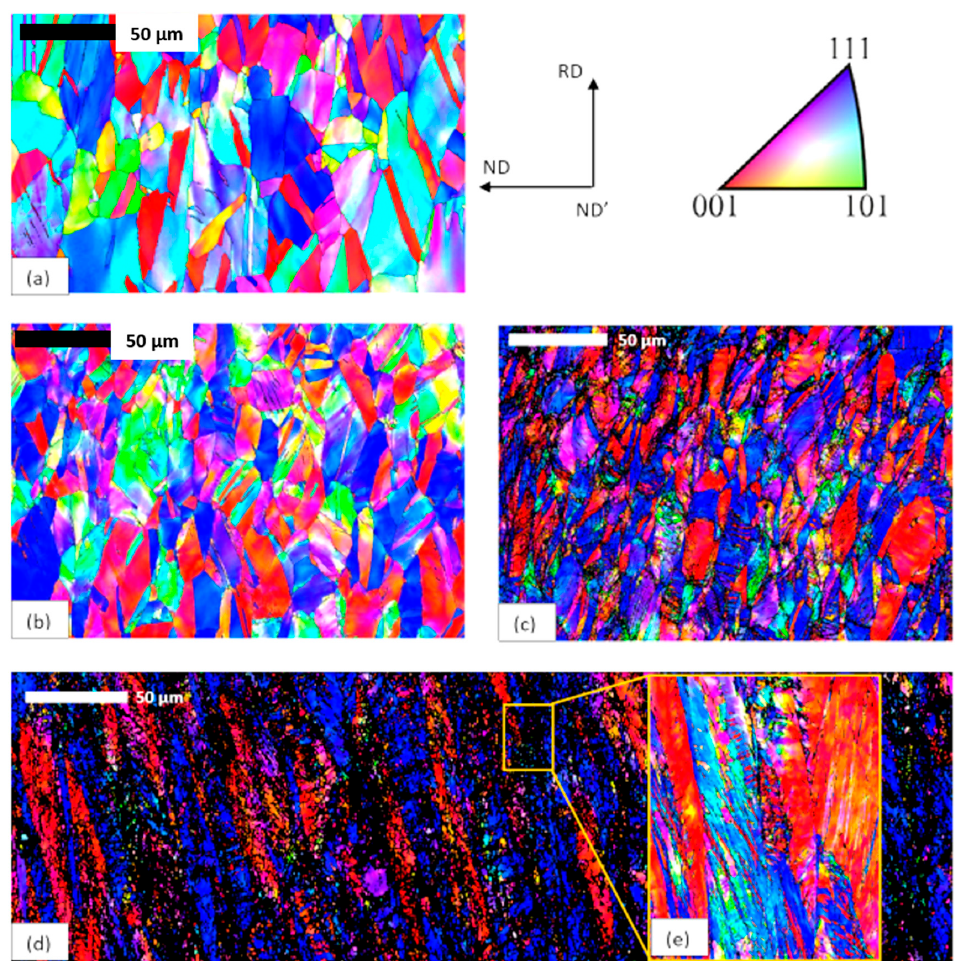
Figure 5. EBSD-band contrast maps described by inverse figure pole (IFP) maps (upper right corner): ( a ) as-annealed; ( b ) after ε = 0.5 by groove cold rolling; ( c ) after ε = 1.1 groove cold rolling; ( d ) ε = 2.2 groove cold rolling; and ( e ) focused area of the image ( d ). Note that magnification is the same for all maps (maps ( d ) corresponding to a stack of 2 EBSD maps with a step size of about 0.2 µm). Table 2. Definition of the texture components in the alloy.